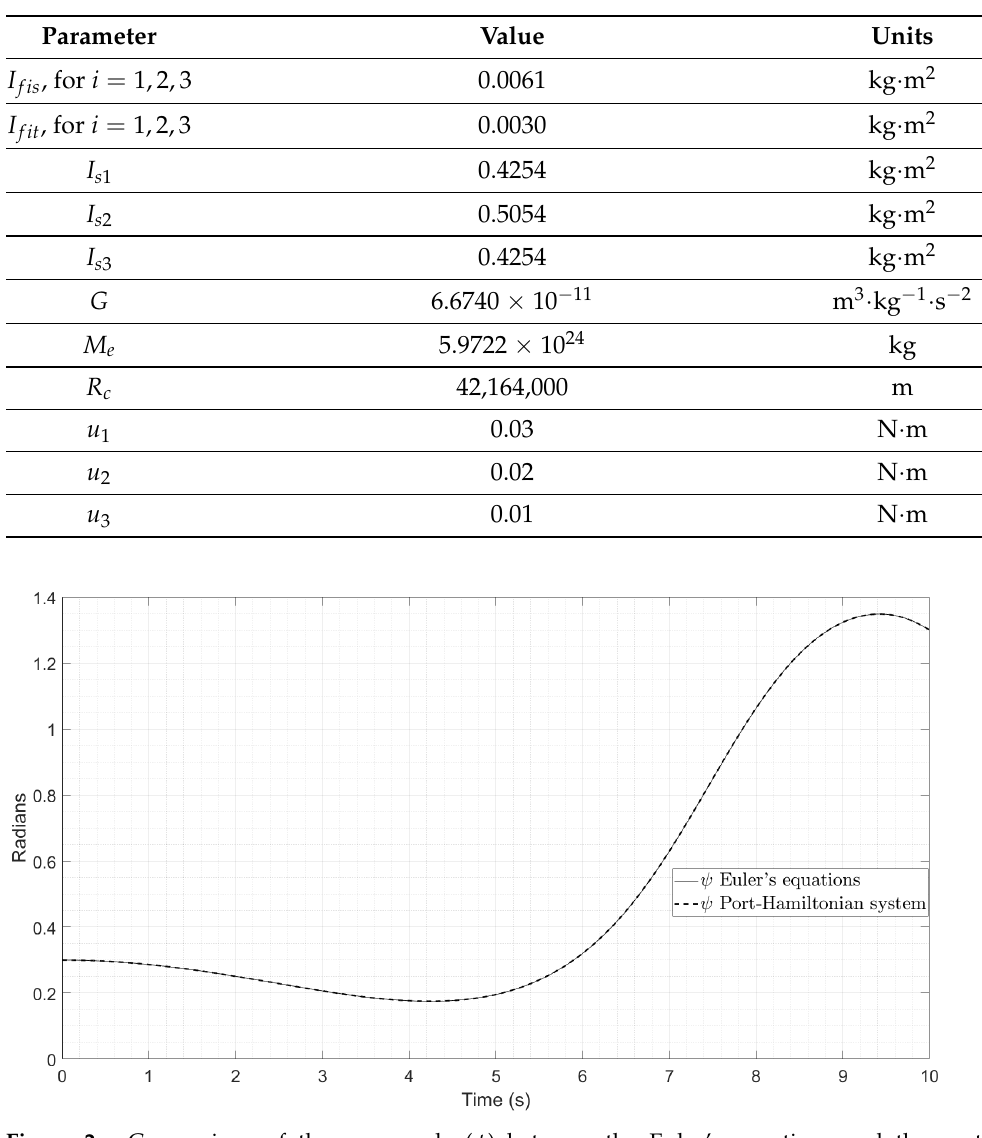
Figure 2. Comparison of the yaw angle ( ψ ) between the Euler’s equations and the port- Hamiltonian